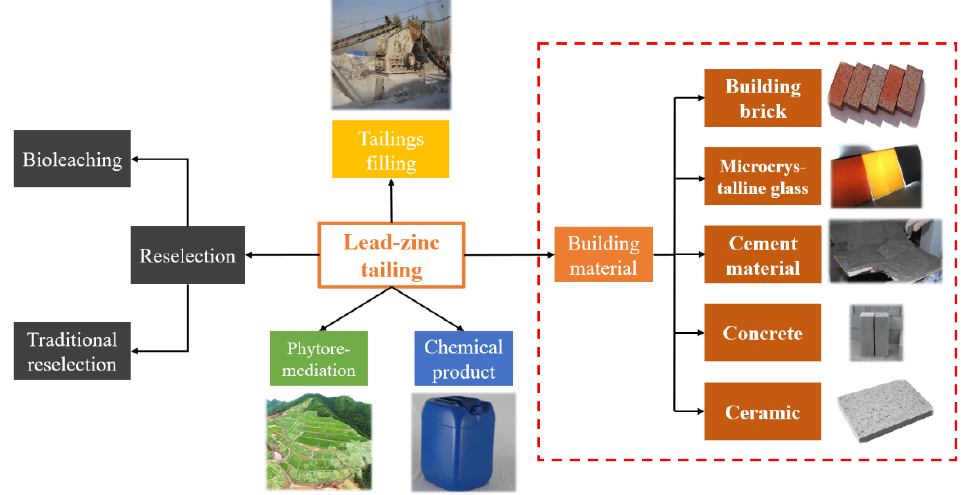
Figure 2. Utilization ways of lead – zinc